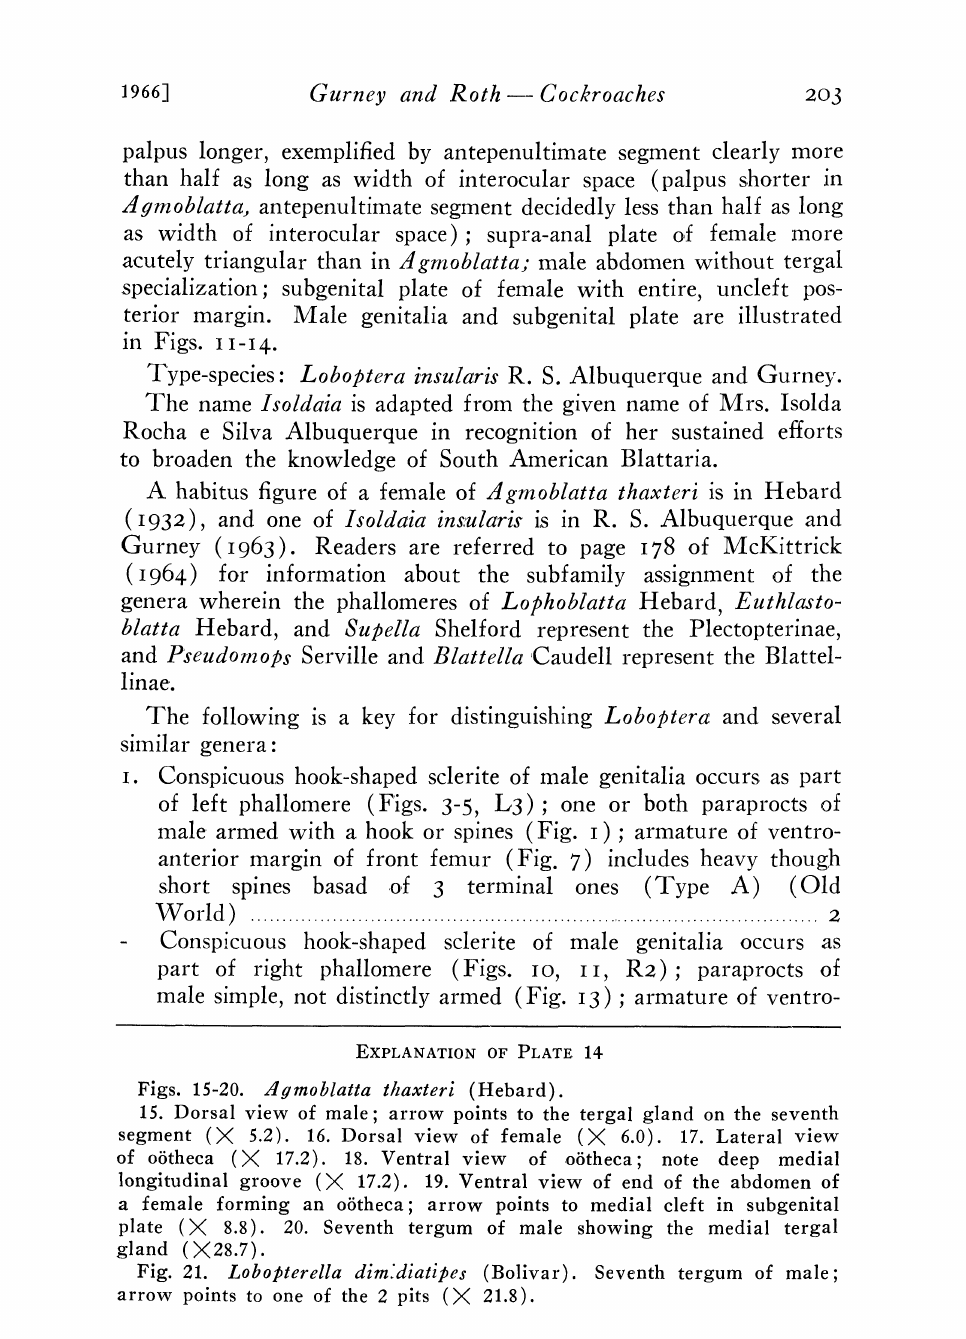
Figs. 15-20. Agmoblatta thaxteri (Hebard). 15. Dorsal view of male; arrow points to the tergal gland on the seventh segment (X 5.2). 16. Dorsal view of female (X 6.0). 17. Lateral view of o/itheca (X 17.2). 18. Ventral view of ,o6theca; note deep medial longitudinal groove (X 17.2). 19. Ventral view of end of the abdomen of a female forming an o6theca; arrow points to medial cleft in subgenital plate (X 8.8). 20. Seventh tergum of male showing the medial tergal gland (X28.7). Fig. 21. Lobopterella dimMiatipes (Bolivar). Seventh tergum of male; arrow points to one of the 2 pits (X